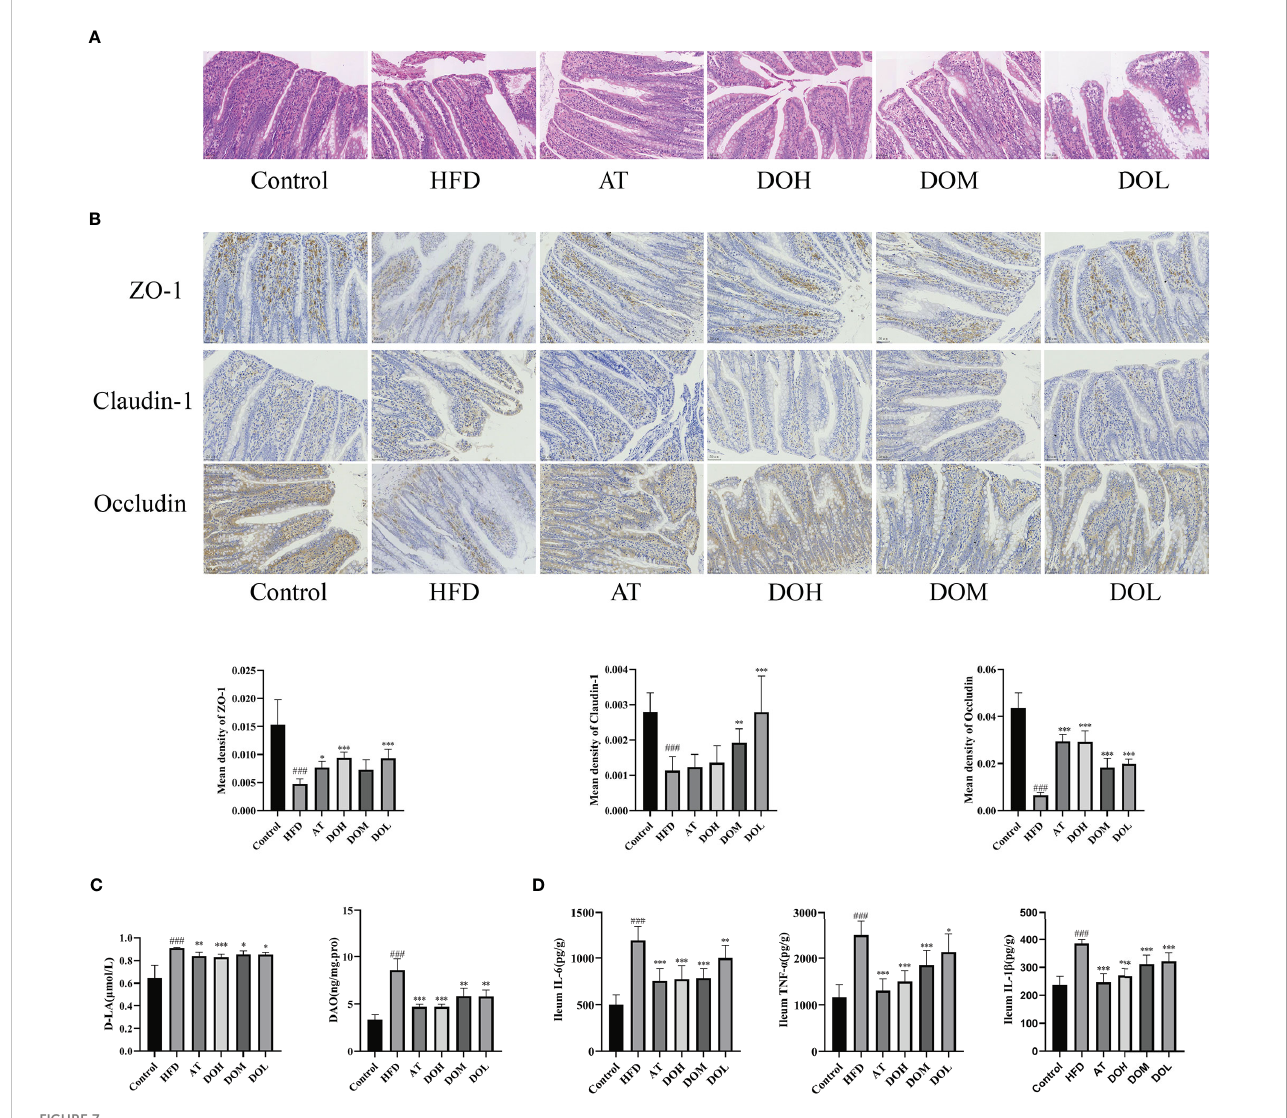
FIGURE 7 Effect of DO on intestinal permeability. (A) Representative images of H&E staining of the ileum by group (400x magni fi cation); (B) immunohistochemistry of the ileal tight junction protein by group (400x magni fi cation); (C) ileum DAO and serum D-LA levels by group; (D) ileum IL-6, TNF- a , IL-1 b levels by group. All data are shown as the mean ± SD (n=8). ### p < 0.001 vs. the Control group; * p < 0.05, ** p < 0.01, *** p < 0.001 vs. the HFD